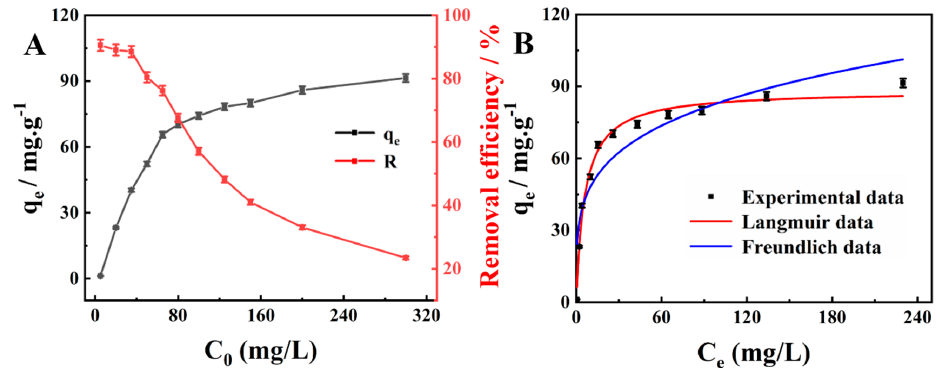
Figure 4. ( A ) Relationship between the initial concentration of AC and the adsorption performance; ( B ) Adsorption isotherms of AC on N-SC/ β -CD-MOFs. Table 2. Adsorption isotherm parameters of AC on N-SC/ β -CD-MOFs. The nonlinear fitting diagram of Langmuir (red line) and Freundlich (blue line) Langmuir Freundlich